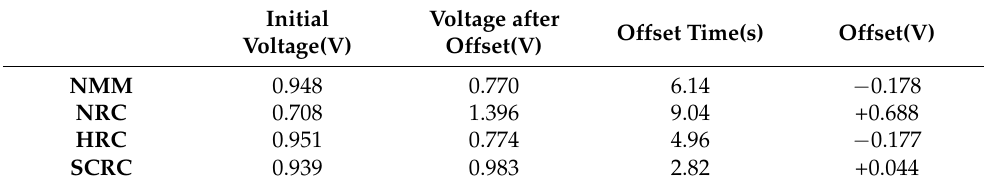
Table 2. Results of continuous reading of logic